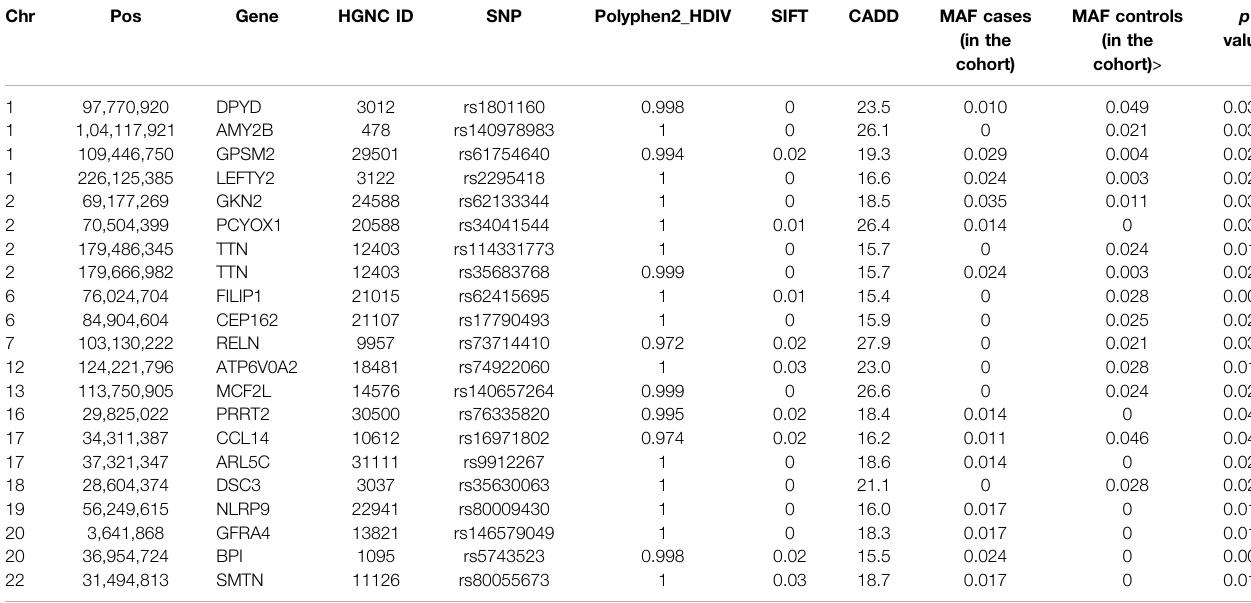
TABLE 2 | Pathogenic, nominally signi fi cant (based on genotype testing, p < 0.05) gene variants identi fi ed by univariate analysis. Genomic positions are based on Human Feb. 2009 (GRCh37/hg19) Assembly. p value represents the genotype testing. Chr Pos Gene HGNC ID SNP Polyphen2_HDIV